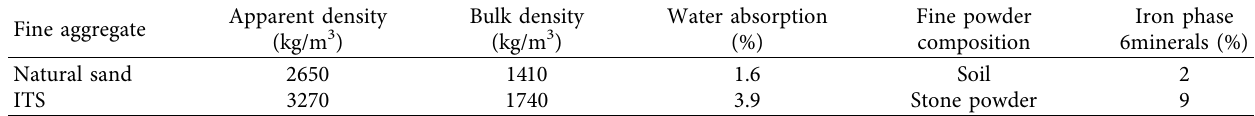
Table 1: Parameter indexes of NS and ITS.